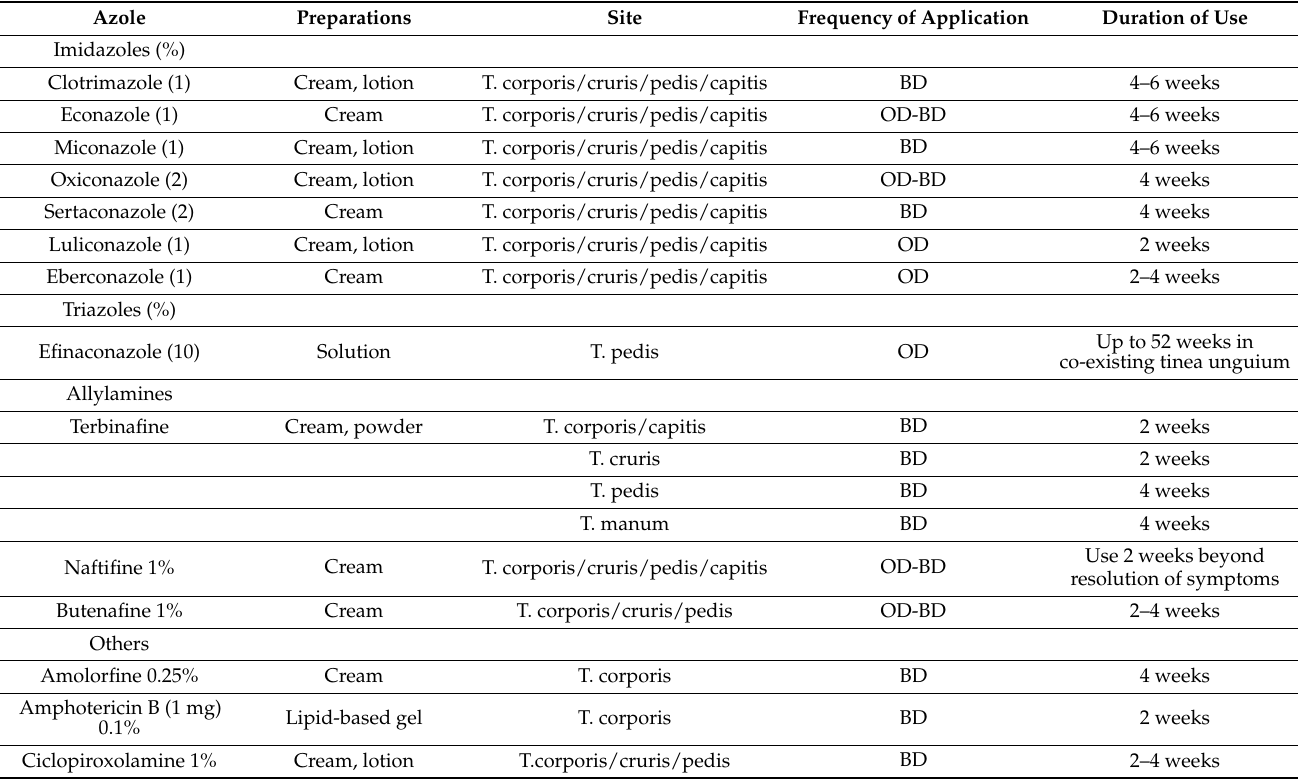
Table 5. Summary of topical antifungals in dermatophytic